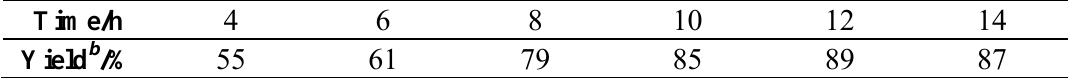
Table 2 Effect of reaction time on the Suzuki reaction a